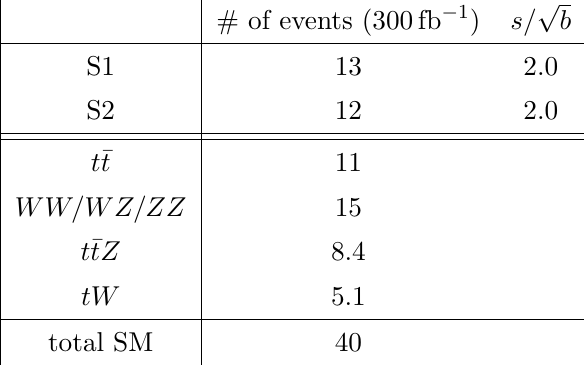
Table 2 . Number of events of signal and backgrounds and the corresponding s= selection cuts for the 2 ‘ + E miss